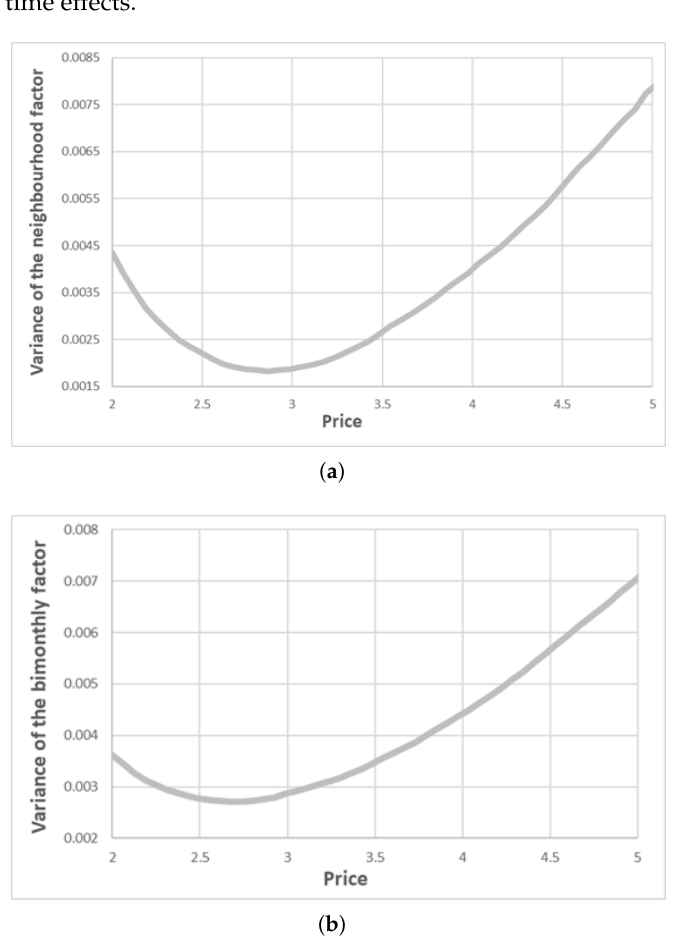
Figure 6. ( a ) Relationship between slope and intercept random neighbourhood effects. ( b ) Variance of the time